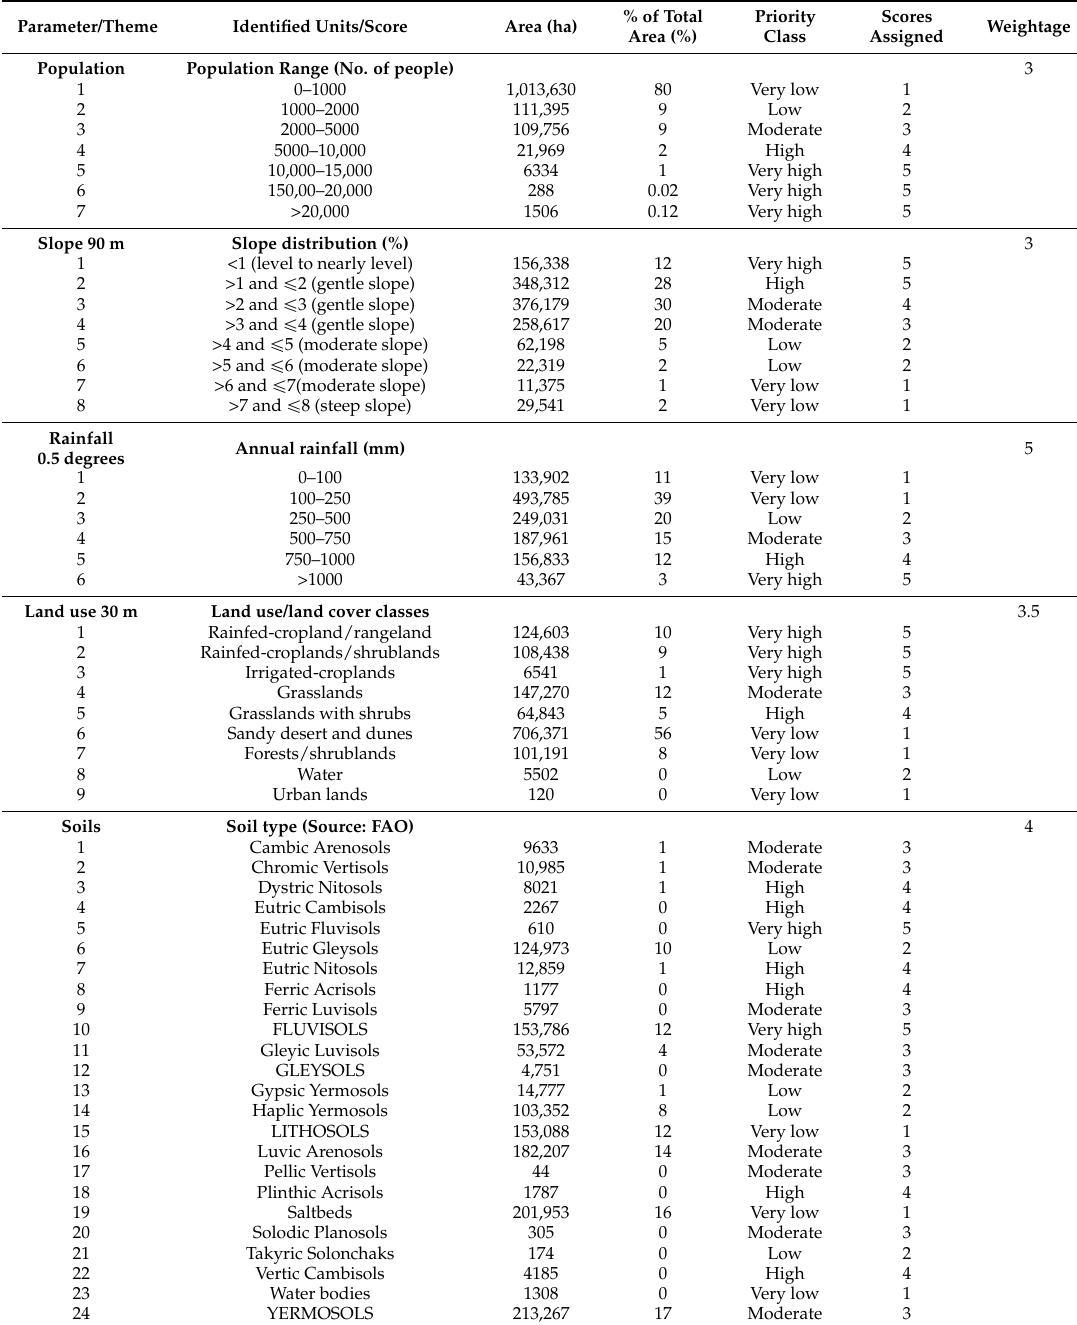
Table 2. Spatial distribution of the various parameters/themes, identified units within each theme and their associated areal extent within the study